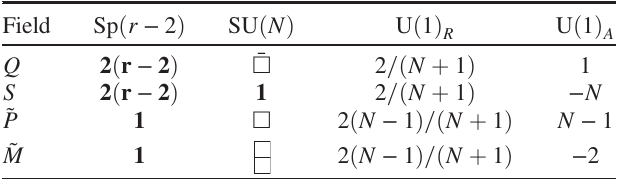
TABLE II. Quantum numbers of fields when N is